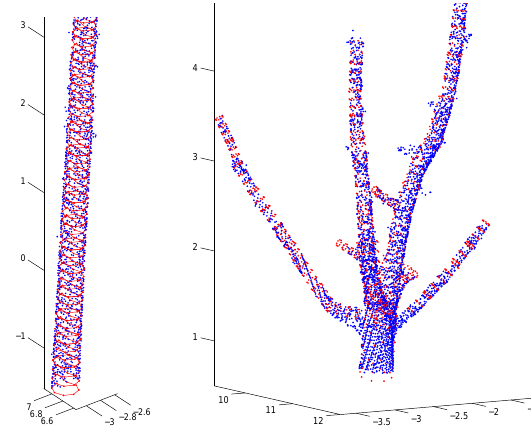
Figure 8: Cylinder fitting for trunk. The point clouds (blue points) are thinned out.